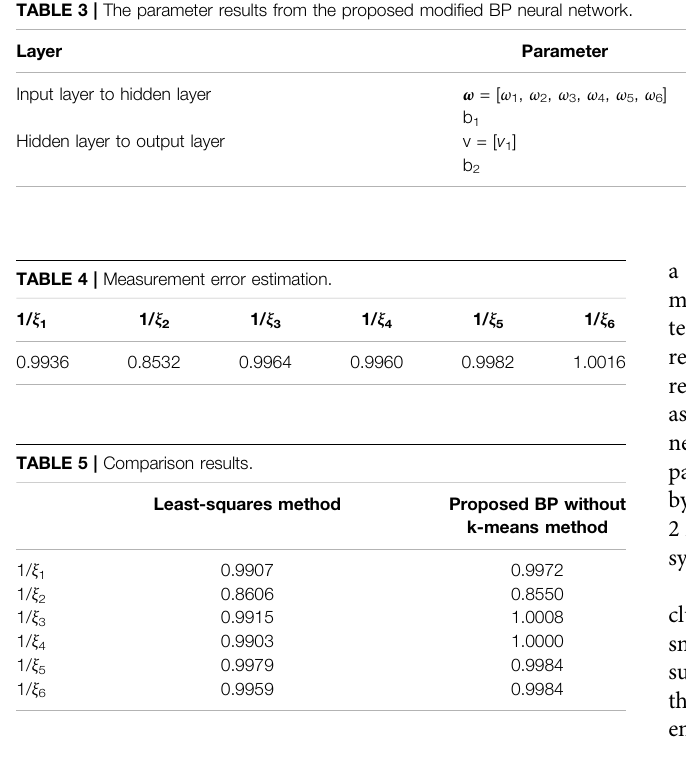
TABLE 6 | Running time. Method Time/s Least-squares